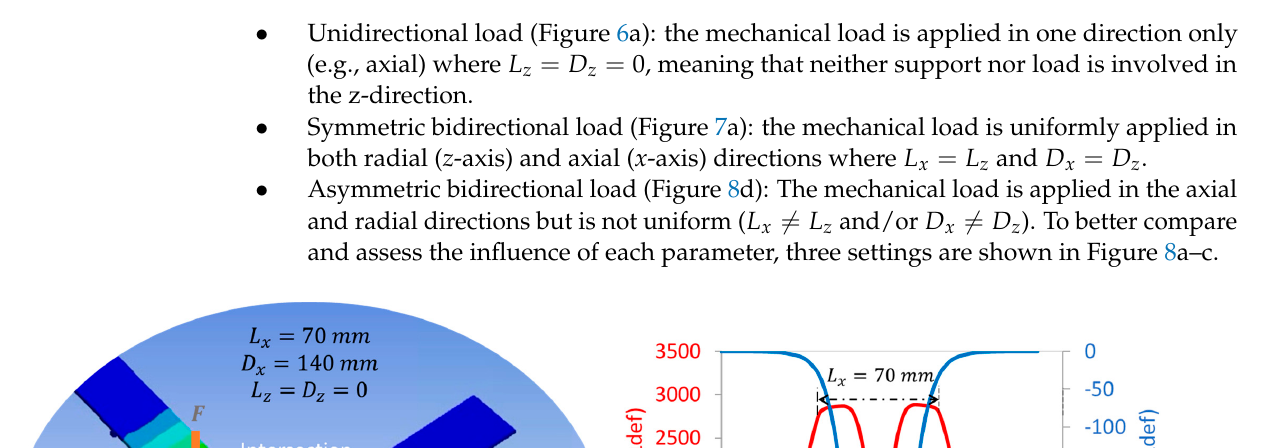
Figure 8. Asymmetric bidirectional model using FEM: strain in both x -axis and z -axis versus their own length with ( a ) 𝐿 (cid:3051) (cid:3405) 𝐿 (cid:3053) and 𝐷 (cid:3051) = 𝐷 (cid:3053) ; ( b ) 𝐿 (cid:3051) = 𝐿 (cid:3053) and 𝐷 (cid:3051) (cid:3405) 𝐷 (cid:3053) ; and ( c ) 𝐿 (cid:3051) (cid:3405) 𝐿 (cid:3053) and 𝐷 (cid:3051) (cid:3405) 𝐷 (cid:3053) , where numerical image is shown in ( d ).